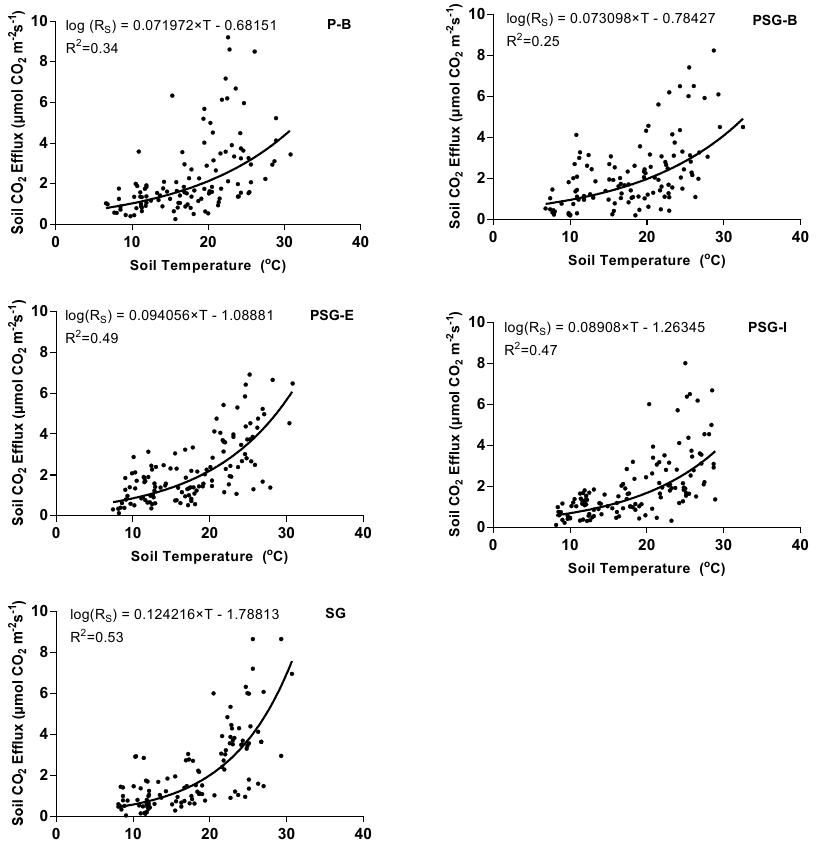
Figure 3. Temperature response of log-transformed soil CO 2 efflux measured approximately every 6 weeks from 10 January 2012 to 20 January 2013 in a four-year-old switchgrass and loblolly pine intercropped system on the lower Coastal Plain of North Carolina. P = pine, SG = flat planted switchgrass, and PSG = pine intercropped with switchgrass. Additional treatment designations